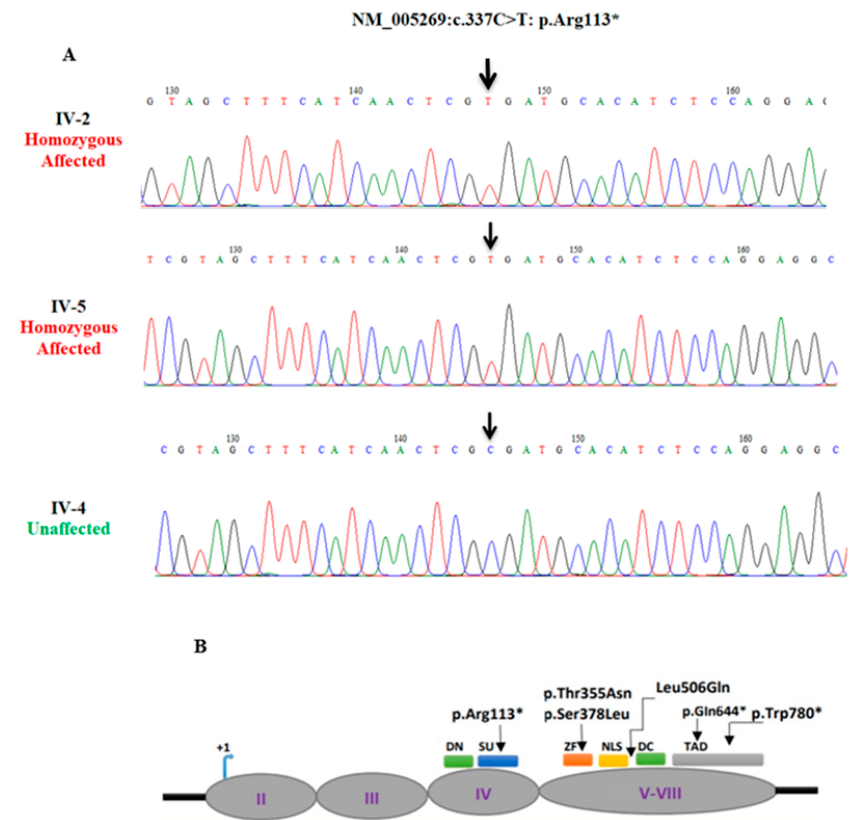
Figure 3. Sequence chromatogram of exon 4 of GLI1 . Panel ( A ) presents individuals IV-2 and IV-5 as homozygous affected and IV-4 as homozygous wild type. Arrow highlights the position of the substitution mutation (c.337C>T: p.Arg113*). Panel ( B ) presents the coding areas of GLI1 and anticipated domains, and the arrows indicate the reported mutations in polydactyly to date. (DN/DC: degron degradation signals, SU: SUFU binding domains, ZN: a zinc finger domain, NLS: nuclear localization signal, TAD: transactivation domain).